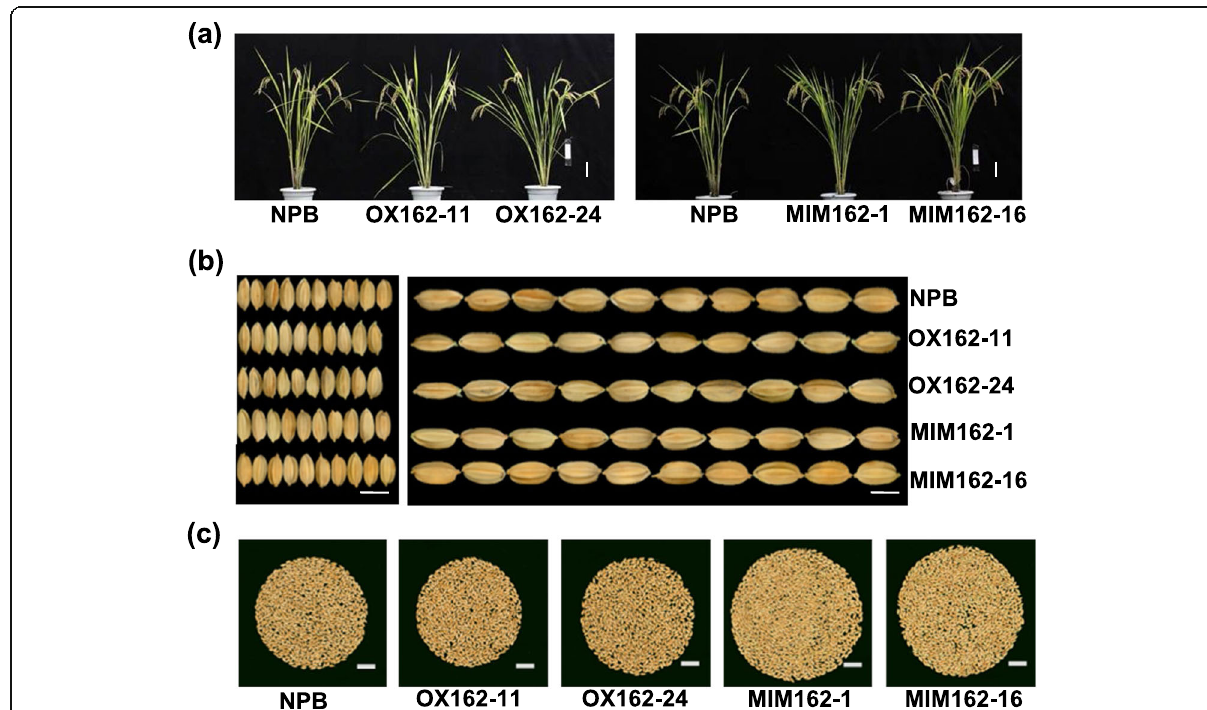
Fig. 6 Osa-miR162a regulates rice yield. a Gross morphology of the wild type (Nipponbare, NPB), OX162, and MIM162 lines. Scale bars, 10 cm. b Photos of grains to show grain length and grain width of NPB, OX162, and MIM162 lines. Scale bars, 5 mm. c Photo of grains per plant of NPB, OX162, and MIM162 lines. Scale bars, 2 cm